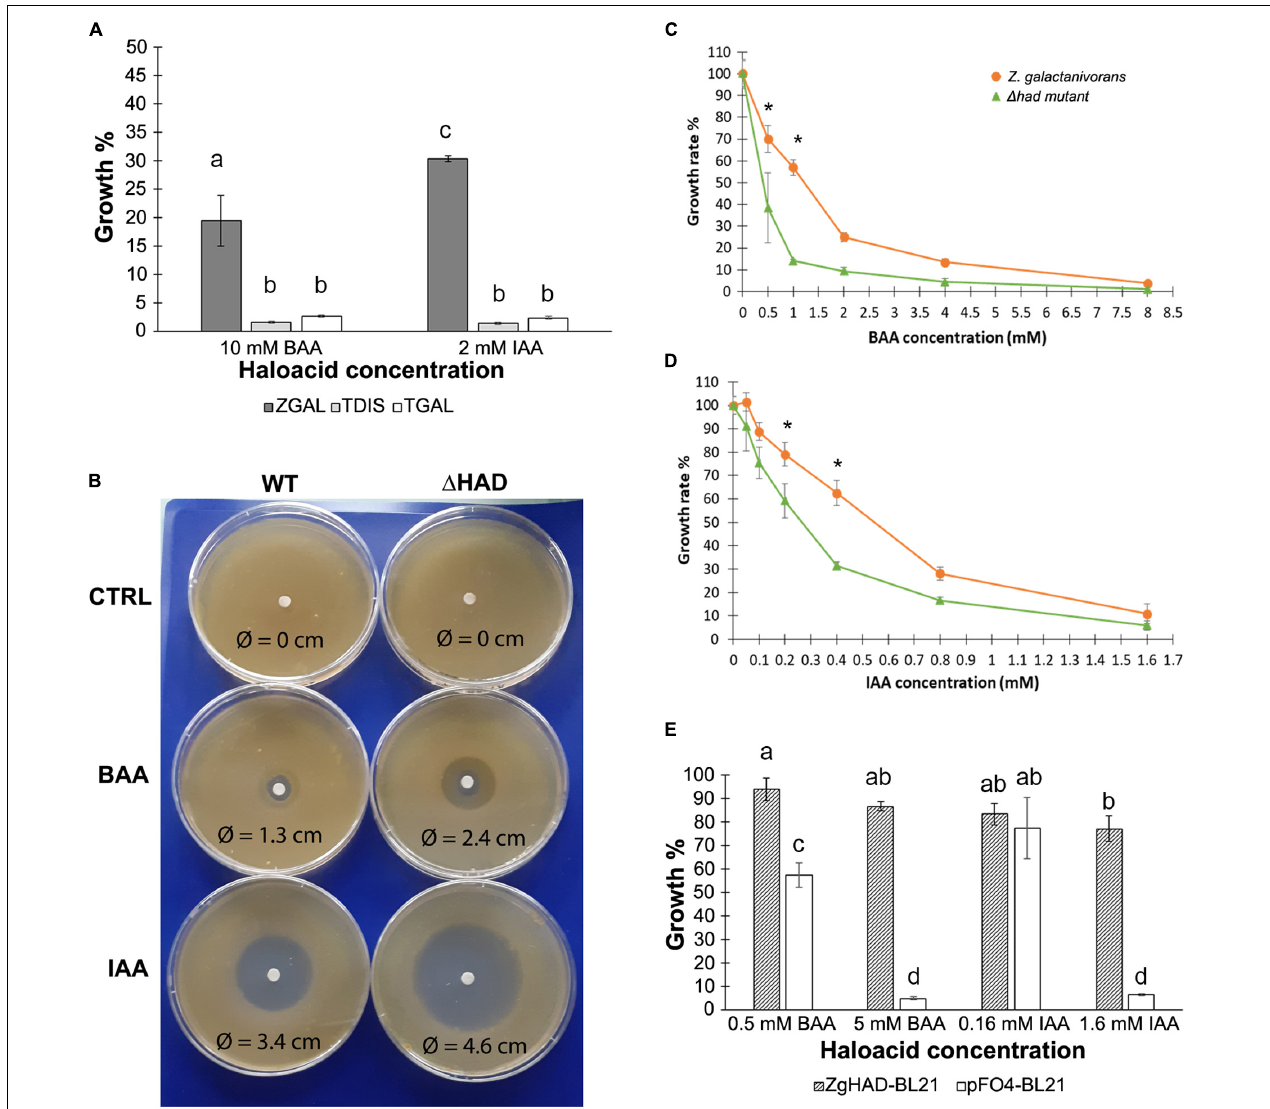
FIGURE 3 | Comparison of bacterial growth of different marine strains, Z. galactanivorans HAD knockout mutant and E. coli recombinant clones in presence of haloacetic acids (A) Growth percentage of Tenacibaculum strains ( T. discolor: TDIS and T. gallaicum: TGAL) compared to Z. galactanivorans wild type (ZGAL) in liquid cultures supplemented with 10 mM bromoacetic acid (BAA) and 2 mM iodoacetic acid (IAA) ( n = 3). (B) Z. galactanivorans WT and (cid:49) had growth on solid medium with BAA and IAA solutions deposited on a filter at the center of the plate. The diameter of inhibition around the disk was measured for each plate after 3 days of incubation at 20 ◦ C. CTRL: negative control (see also Supplementary Figure 4 ). (C,D) Growth rates of Z. galactanivorans wild-type and (cid:49) had mutant in liquid cultures with different concentrations of BAA (C) and IAA (D) . Z. galactanivorans (orange line, round dots) and (cid:49) had mutant (green line, triangle dots) ( n = 3). (E) Growth percentage in liquid cultures supplemented with either 0.5 or 5 mM BAA and 0.16 or 1.6 mM of IAA compared to the unamended medium (100%) of the ZgHAD-expressing recombinant E. coli strain (ZgHAD-BL21) and the E. coli control strain (pFO4-BL21) ( n = 3). Letters and stars indicate statistically significant differences between treatments (A,E) and between WT and (cid:49) had mutant strains (C,D) for the same culture condition (two-way ANOVA, Tukey’s post hoc tests, p < 0.05).